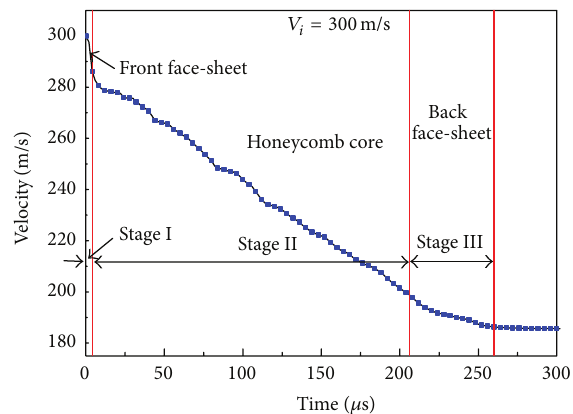
Figure 4: The evolution of projectile velocity in perforating the A- type HSP at 𝑉 𝑖 = 300 m/s.